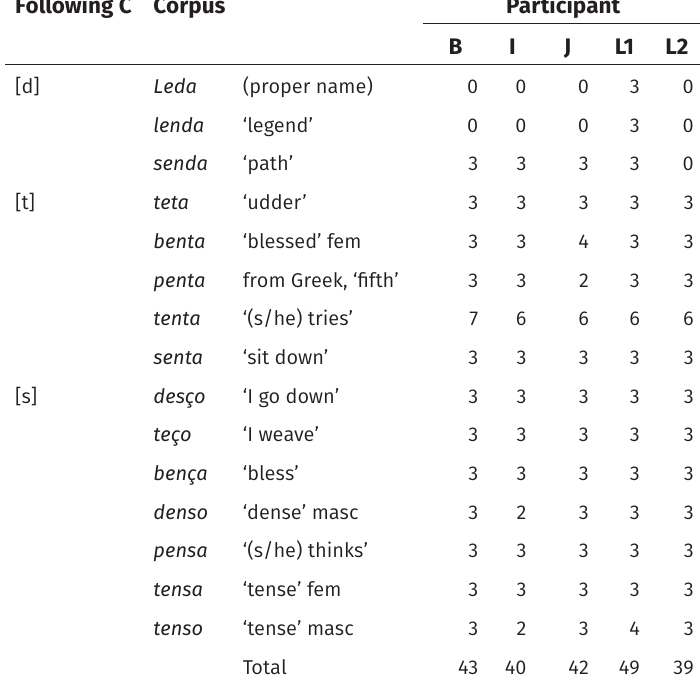
Table 2: Repetitions by participant and word in the corpus (<n> orthographically indicates nasality on the previous